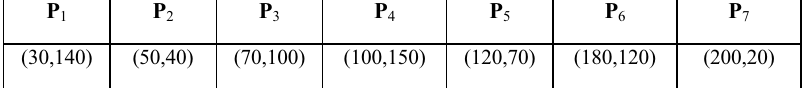
Table 2. Positions of goal, object and fuel station in two problem cases studied in simulations. CASE